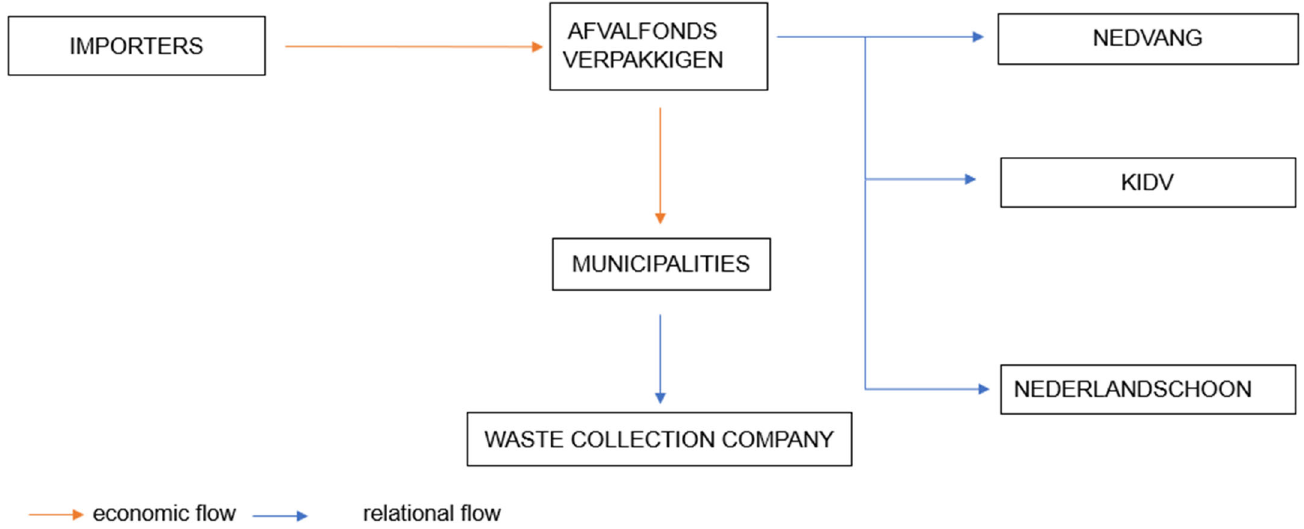
Figure 4. Dutch model. Source: own elaboration based on [34].